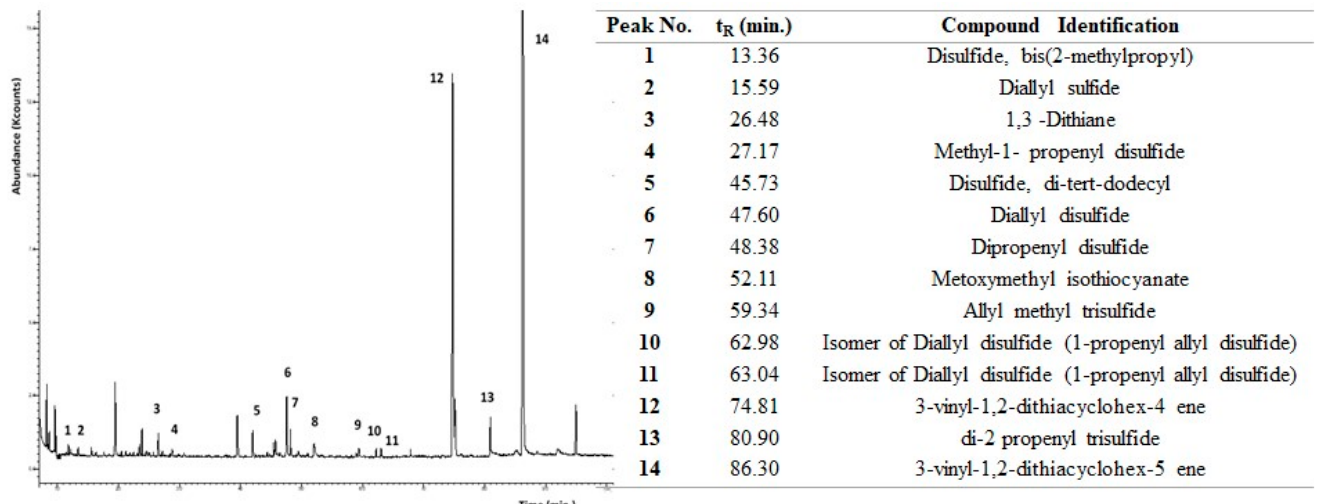
Figure 1. GC/MS chromatogram of OSCs detected in VGE fresh extract and the identification of the major peaks using EI mass spectra information and NIST library data.